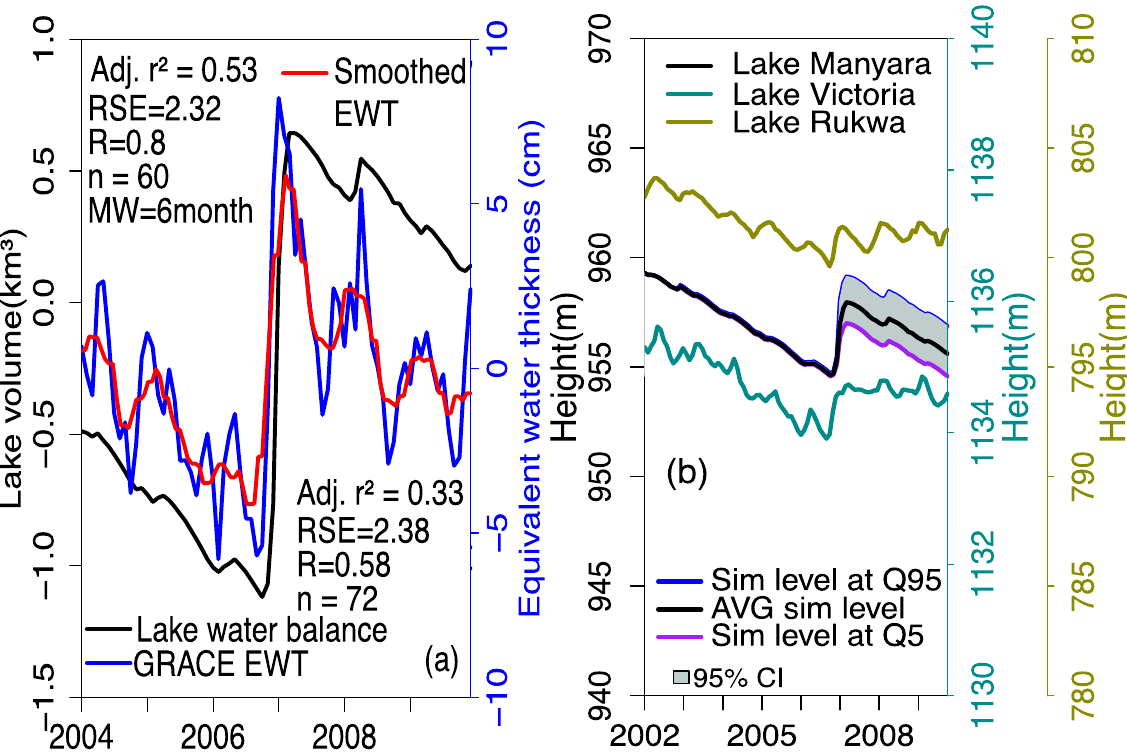
Figure 15. ( a ) Lake water balance trend as compared to satellite gravimetry GRACE equivalent water thickness data. GRACE EWT data are smoothed with a six month exponential moving average window; ( b ) Lake Manyara simulated water surface height variation at 95% confidence interval (CI) as compared to neighboring lakes in East African